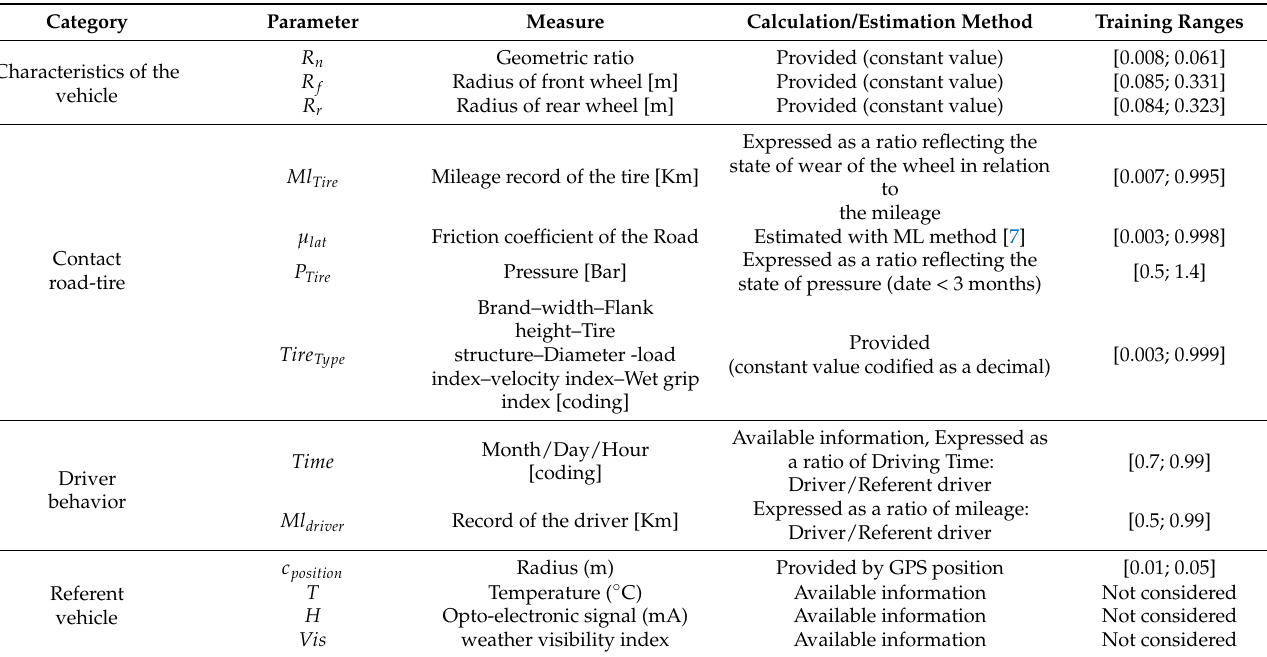
Table 2. Parameters used in algorithms for cornering assistance